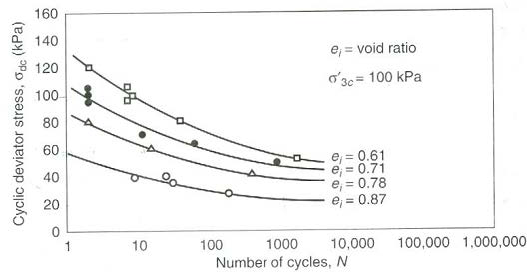
Figure 4. Cyclic test results on Sacramento River Sand (Kramer, 1996)